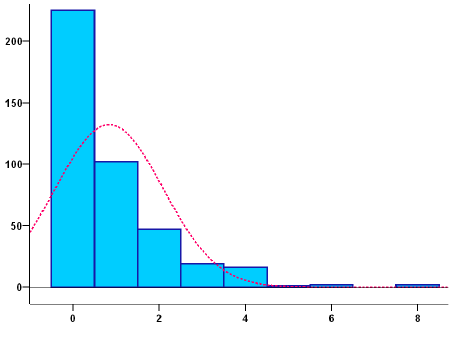
Figure 3. Number of falls.